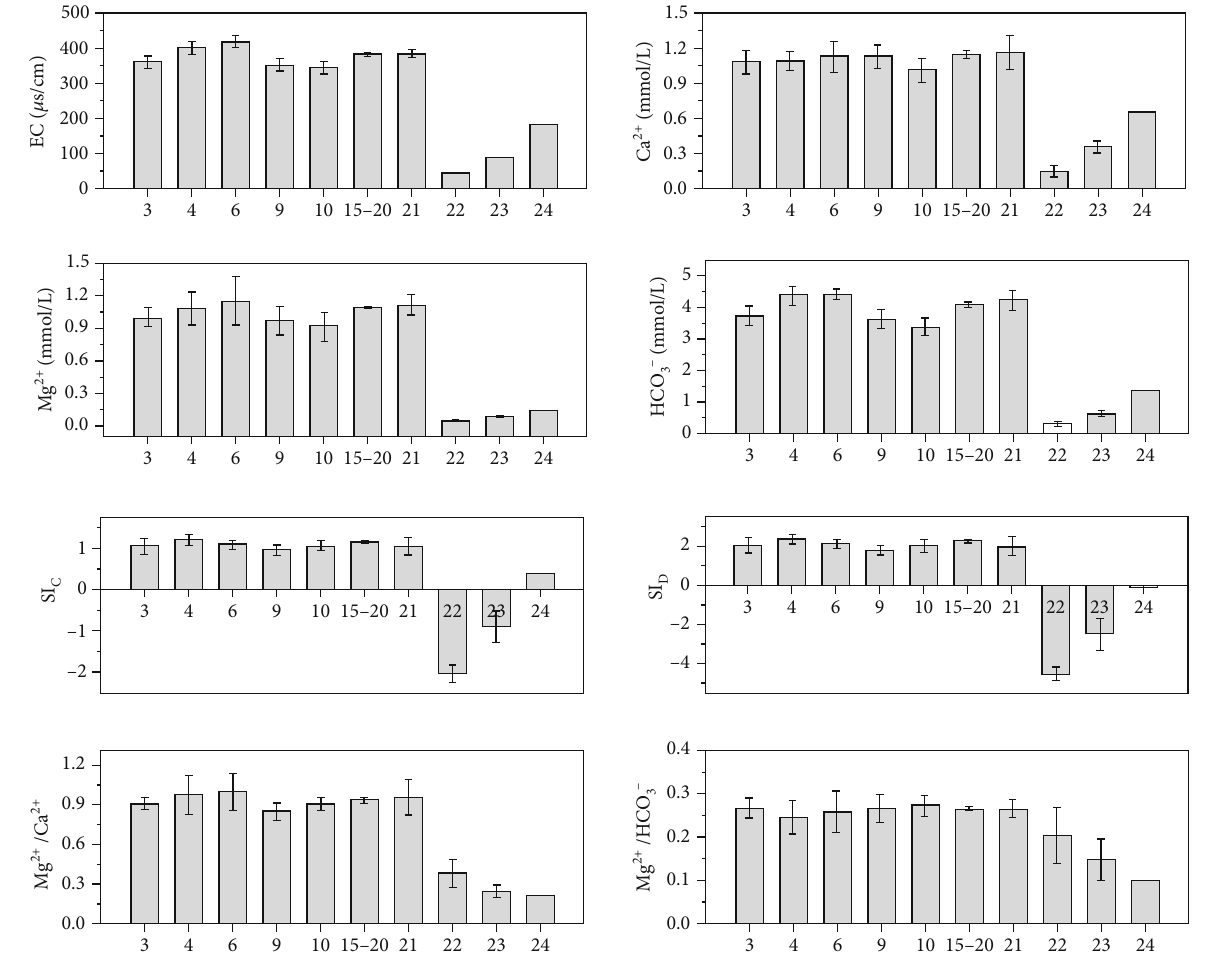
Figure 4: Space variation of the hydrochemistry of waters in Shanmuhe